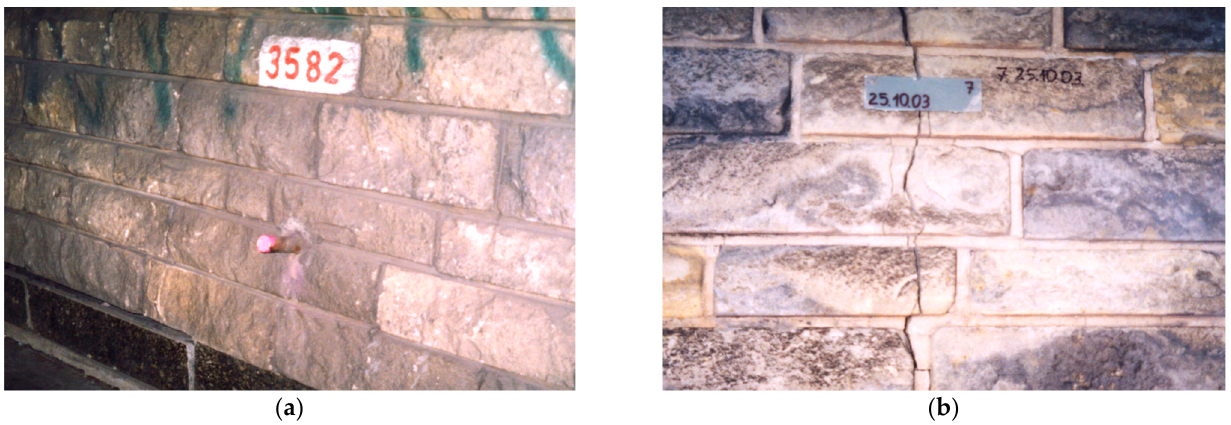
Figure 2. Applied monitoring of the impact of the investment projects on neighboring facilities: ( a ) measurement benchmark; ( b ) sealant for observation of crack development.